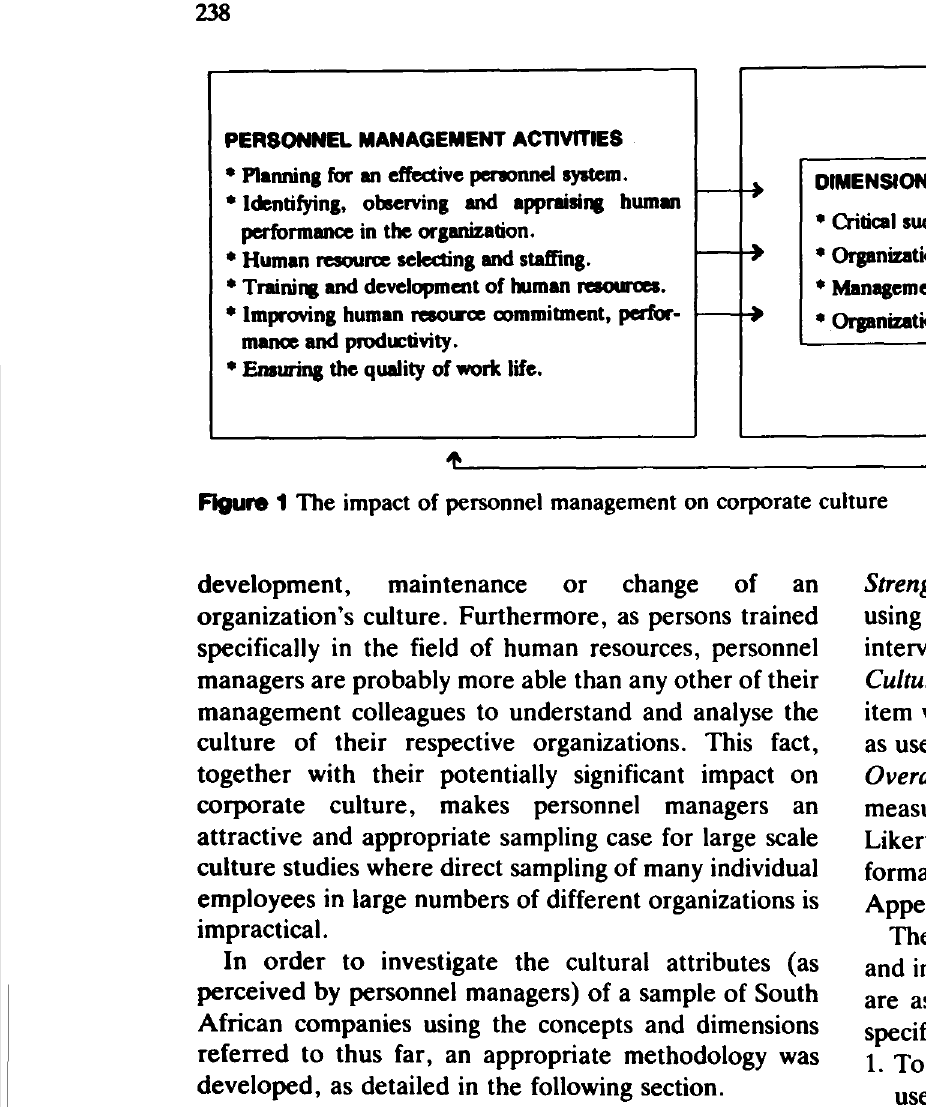
makes personnel managers